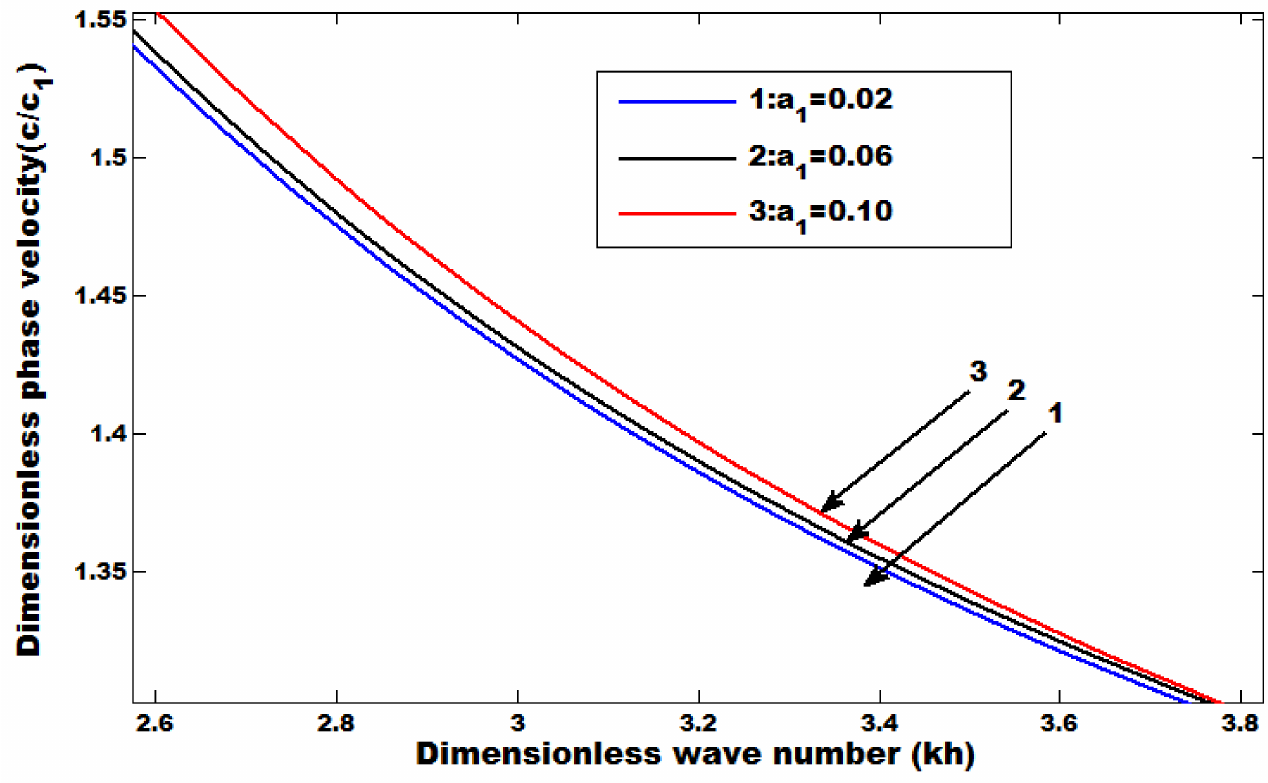
Figure 8. The phase velocity with wave number when m = 0.08, a 2 = 0.2, h = 0.04, p = 0.01, α = 0.2, β =